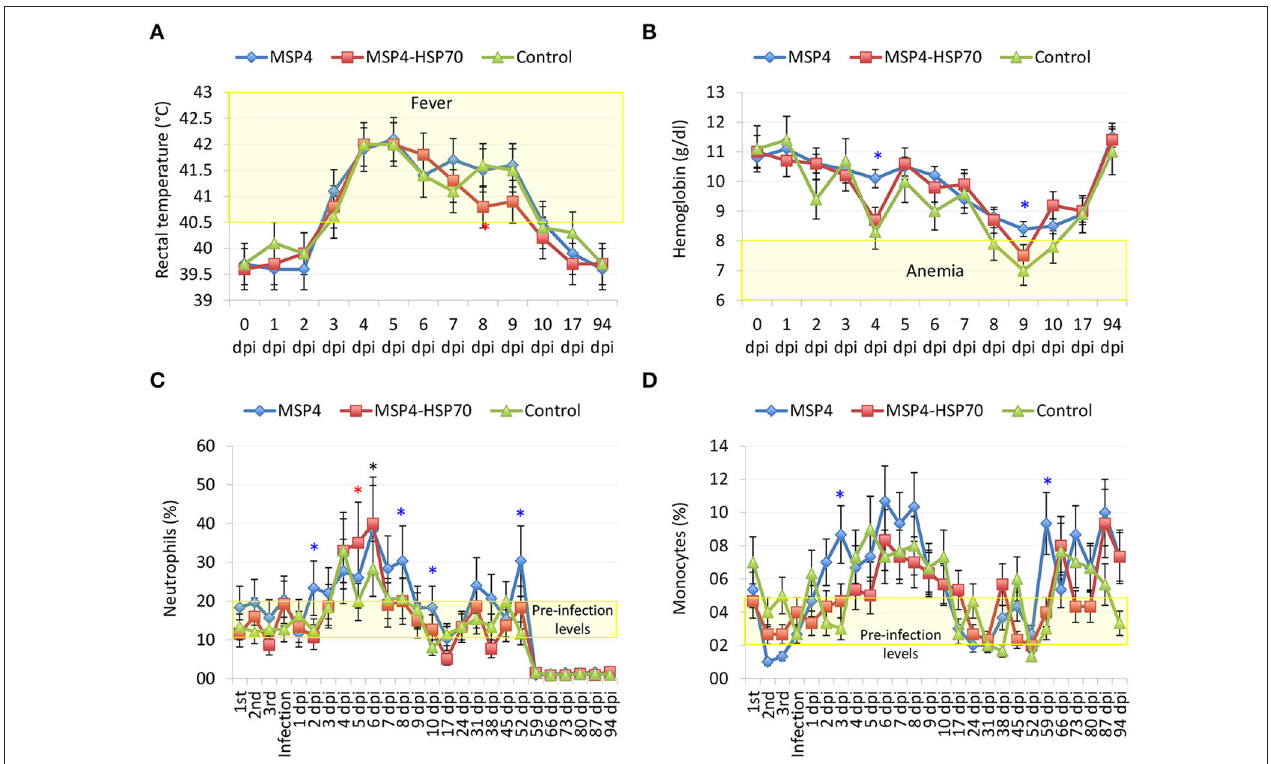
FIGURE 3 | Evidence of TBF in lambs experimentally infected with A. phagocytophilum sheep isolate. Groups of three lambs each were immunized with recombinant MSP4, MSP4-HSP70 combination or adjuvant/saline control and experimentally infected with a sheep isolate of A. phagocytophilum . (A) Rectal temperatures were taken daily until 10 dpi and then weekly until 94 dpi. (B–D) Whole blood was collected in EDTA-containing tubes from the jugular vein of each lamb at different time points for different hematological analyses including (B) hemoglobin, and percent (C) neutrophils and (D) monocytes for leukocyte cell differentiation using an electronic counter (Hemavet 950, Drew, USA). Results from rectal temperature and hematological analyses were compared between immunized and control groups by two-way ANOVA test (* P < 0.05; N = 3 replicates per treatment). Red and blue asterisks denote statistical significant differences between MSP4-HSP70 and MSP4 immunized animals and controls,